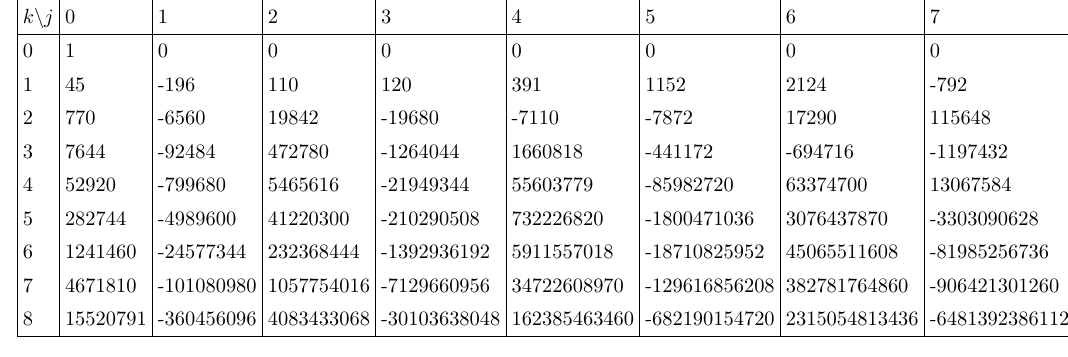
Table 45. Table of b jk coe(cid:14)cients for h SO(10)